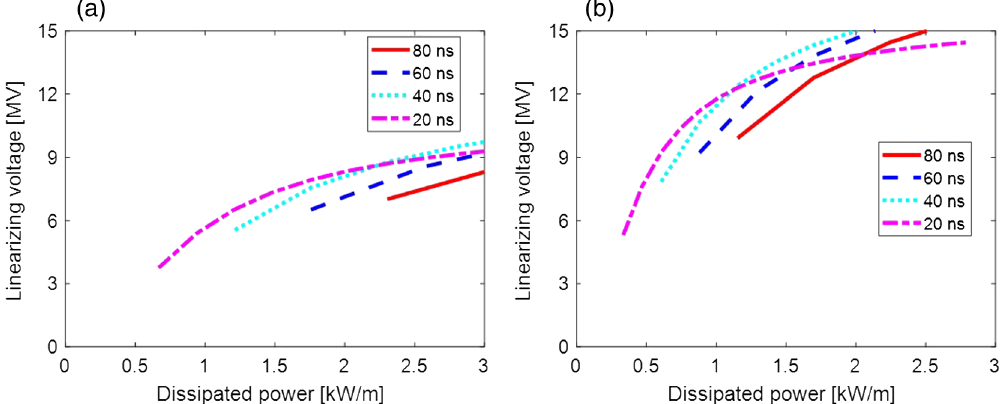
FIG. 20. Linearizing voltage as a function of dissipated power per unit length and pulse length for (a) Two SWS; (b) Four